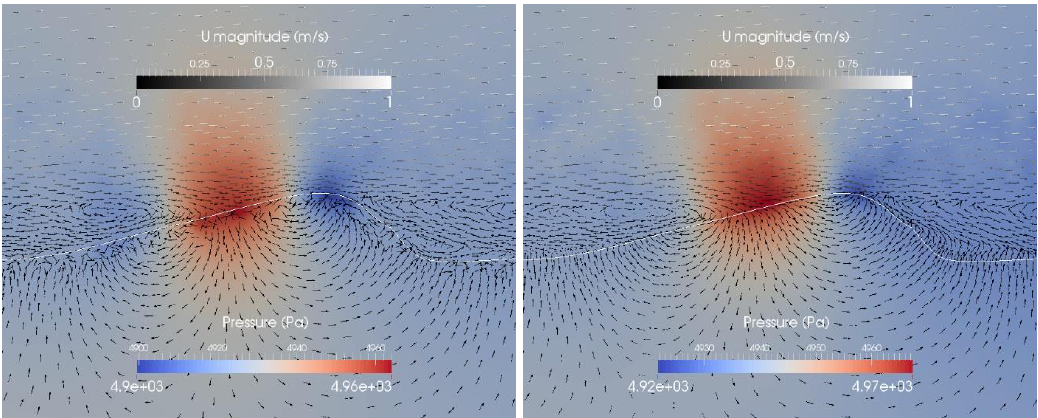
Figure 10. Pressure distribution and velocity vectors at a sandy ( left ) and gravel ( right ) ripple for case 4 (Table 1). The white line indicates the sediment-water interface. The colors indicate the pressure distribution. Please note that the scaling is different in the right and the left panel. The arrows indicate flow directions of the surface and the subsurface flow. To visualize the intensity of the flow U a grey is used.